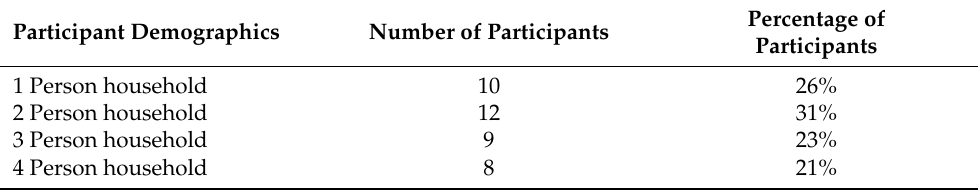
Table 2. Demographic information for each of the 39 citizen scientists located across the Susquehanna River basin in the northeastern United States who volunteered to calculate and share their endocrine- disrupting compound (EDC) footprint.